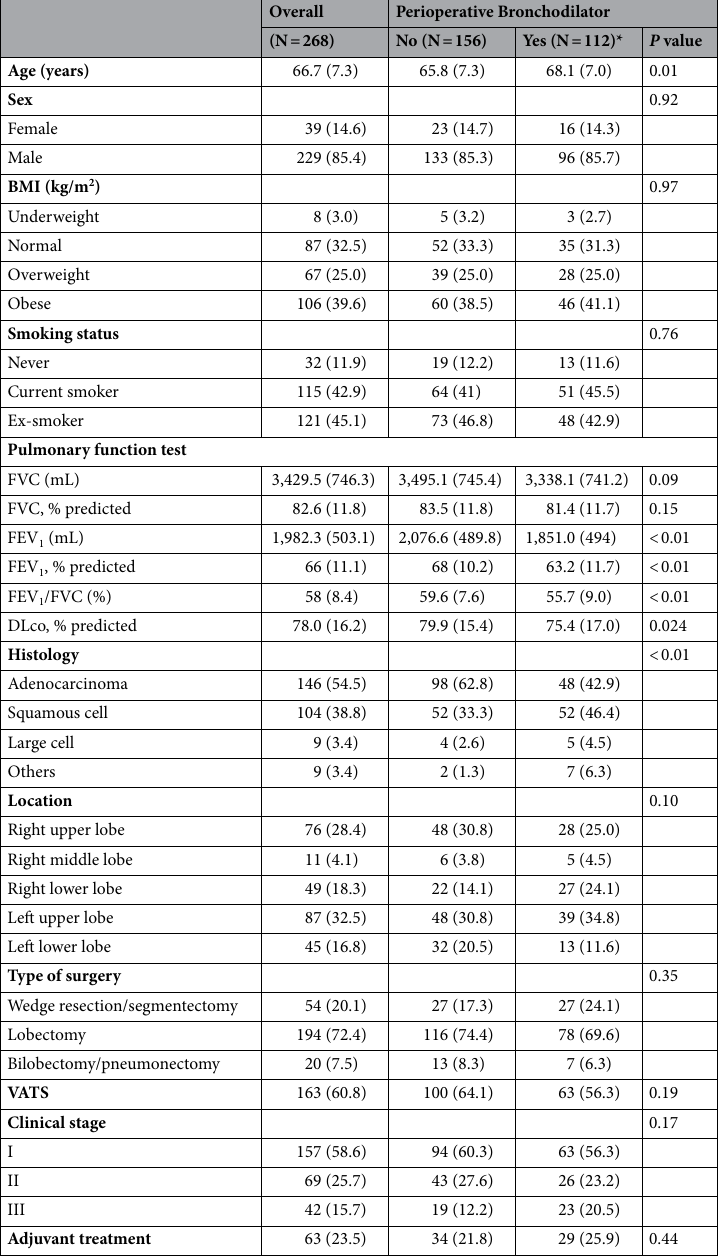
Table 1. Characteristics of all study participants according to perioperative bronchodilator use. Values in the table represent means (standard deviation), or numbers (percent). BMI body mass index, FEV 1